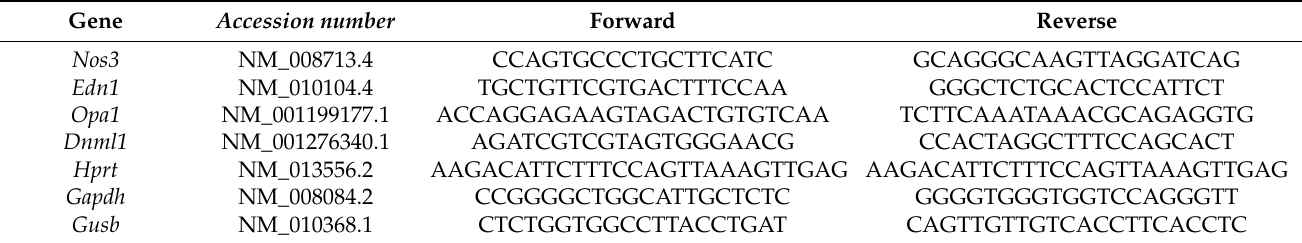
Table 1. List of the primers used for